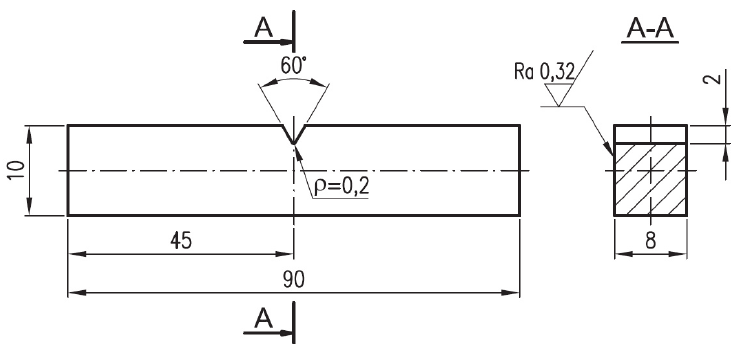
Figure 1: Shape and dimensions of specimen (in mm).